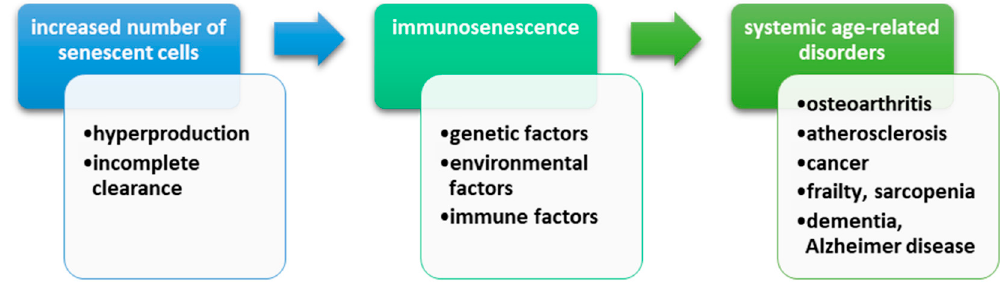
Figure 9. The mechanism of age-related disorders. Senescent cells have an important role in aging through the secretion of matrix-degrading proteins and proinflammatory cytokines, which is called “senescence-associated secretory phenotype”. The number of senescent cells increases during lifetime. This numerical growth is possible through two mechanisms: either production is faster than disposal, or there is an incomplete clearance. Furthermore, senescent cells, though a precise pathway that involves the release of certain mediators and the stop of proliferative activity, can determine their clearing and tissue regeneration. This process is affected in old tissues, leading to the accumulation of these senescent cells. A direct link between senescent cells and age-related systemic diseases (atherosclerosis, osteoarthritis, cancer, sarcopenia, Alzheimer’s disease) has been demonstrated by in vivo studies that have revealed these cells in the affected tissues.